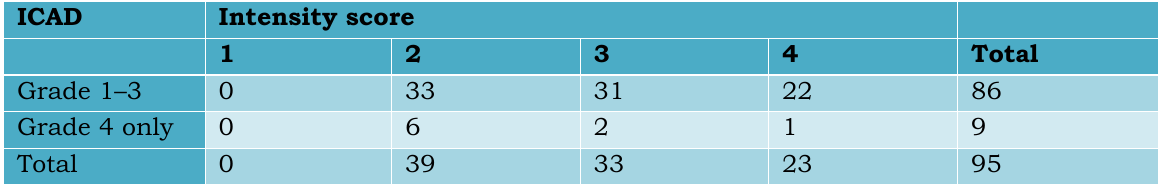
Table 3. Comparison of RCC tumour grade with ICAD protein intensity (Pearson  2 ) ICAD